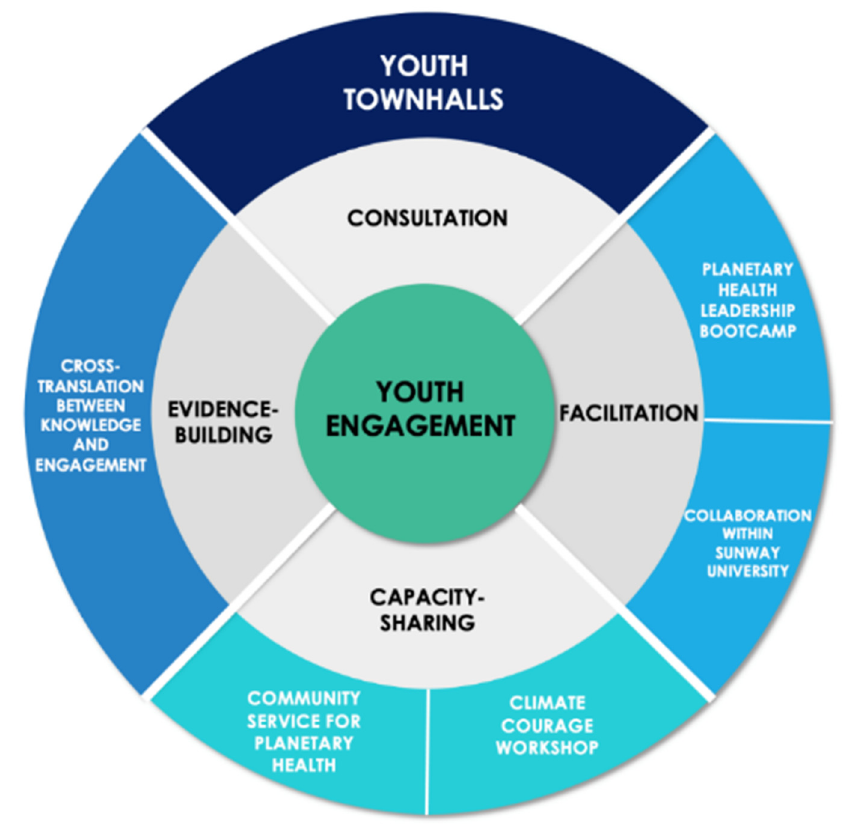
Figure 1. Sunway Centre for Planetary Health’s 2021–2022 Youth Engagement Strategy.